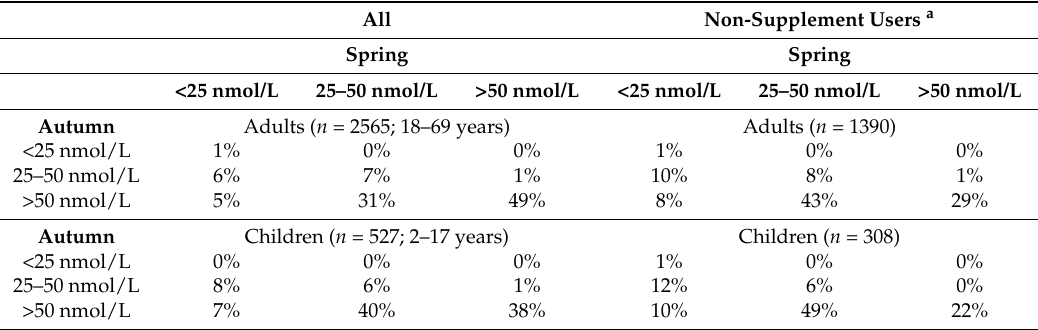
Table 3. Vitamin D status in autumn and spring cross-tabled among adults and children and restricted to non-supplement users for both age groupings.